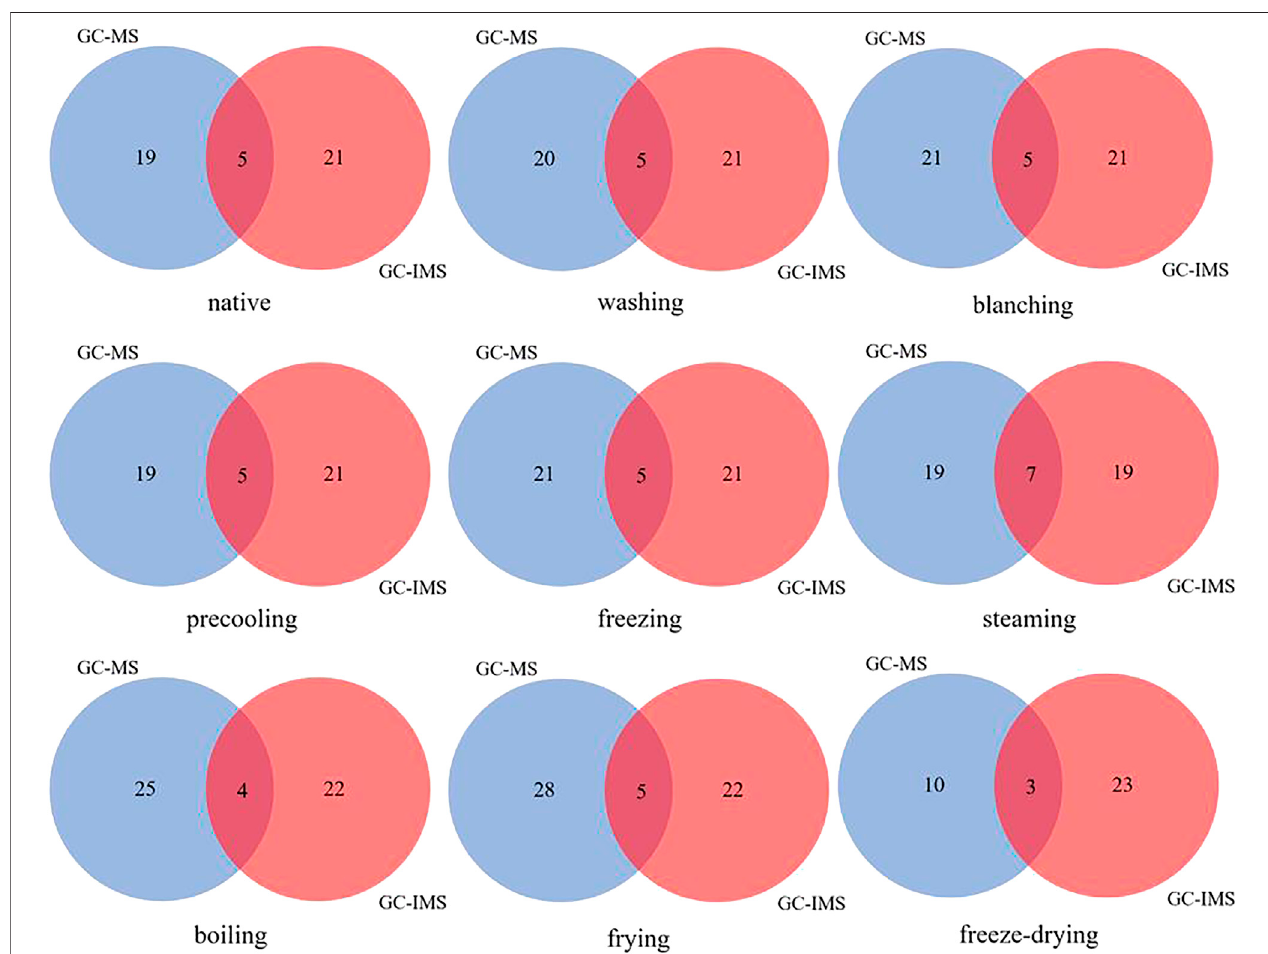
FIGURE 3 | Wayne diagram of the fl avor by GC-MS and GC-IMS under nine kinds of different treatments.